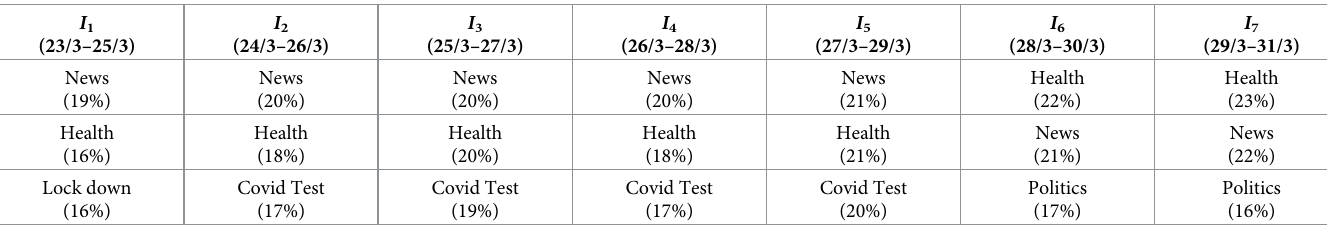
(we consider seven time intervals where len = 3 and Δ t = 1). m